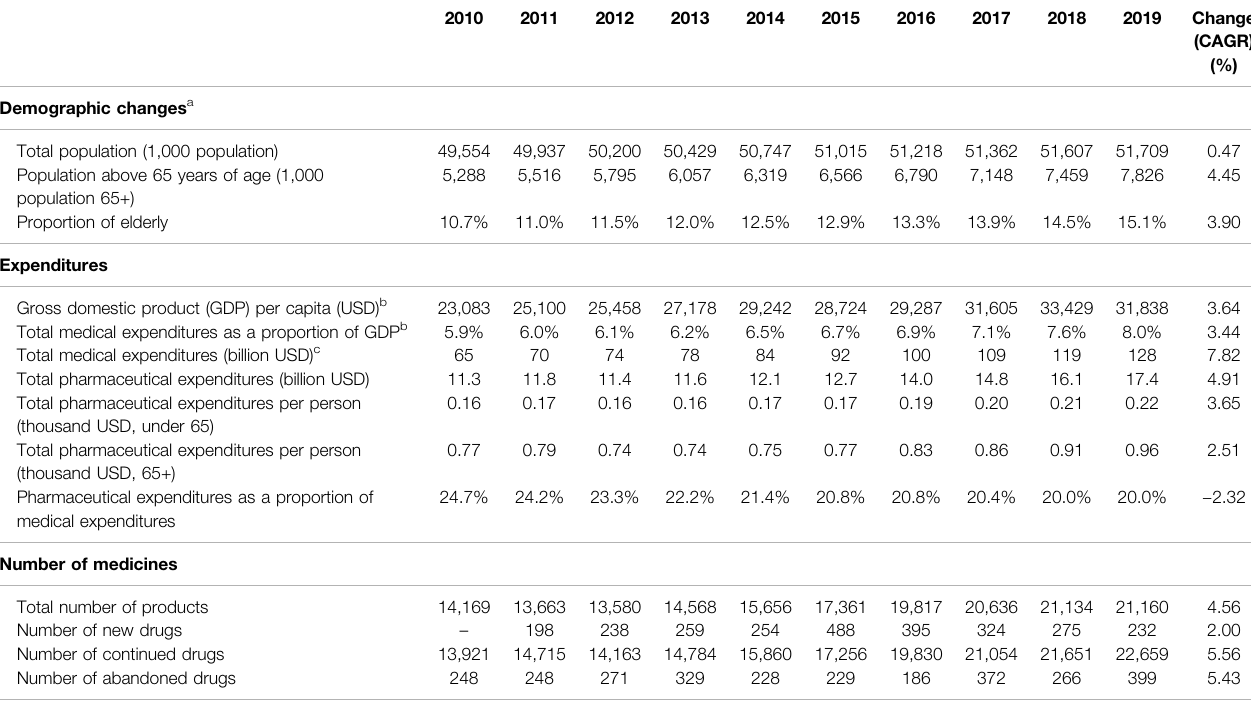
TABLE 1 | Trends in pharmaceutical expenditures and economic and demographic changes by year.